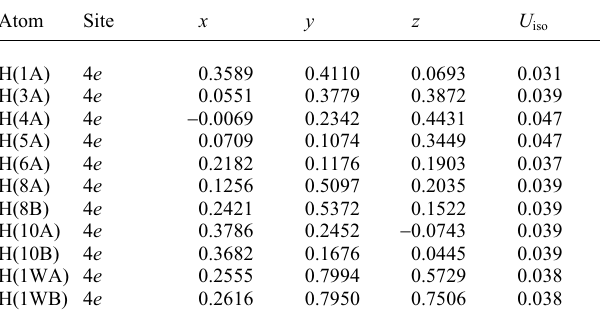
Table 2. Atomic coordinates and displacement parameters (in Å 2 )